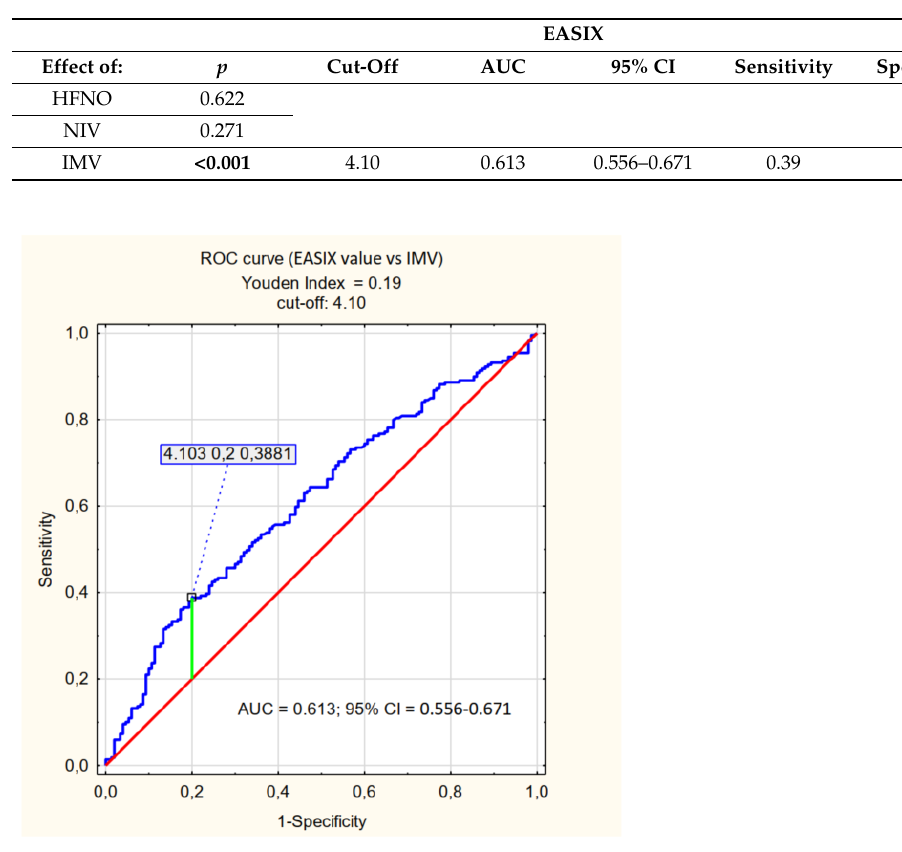
Figure 4. ROC curve (effect of EASIX value on IMV).